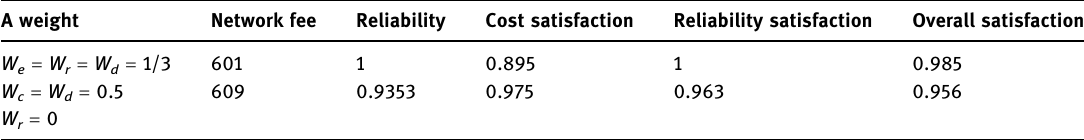
Table 2: Performance indexes and GA optimization results under di ff erent weights A